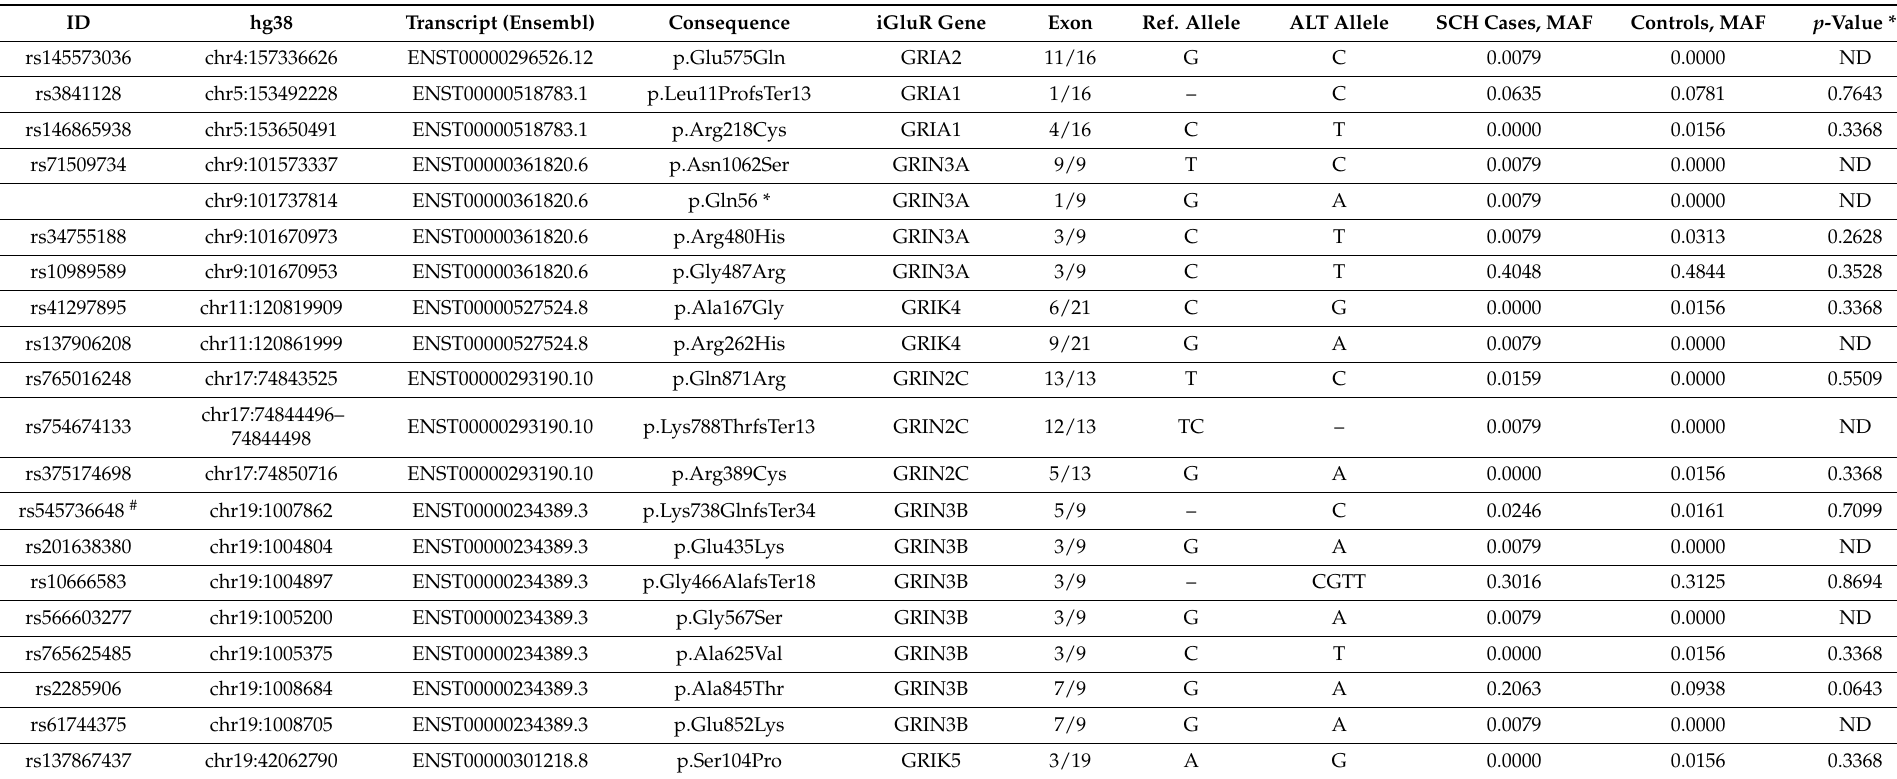
Table 3. Missense variants of iGluR genes with assigned deleterious effect. The list shows nonsense, frameshift, and missense variants of iGluR genes. Missense variants were classified as deleterious by at least five prediction tools and must have a CADD_phred value above 20. The corresponding minor allele frequencies (MAF) in the SCH subjects and the healthy controls with assessed p -values are shown (ND = not determined due to low frequency of the variant in both